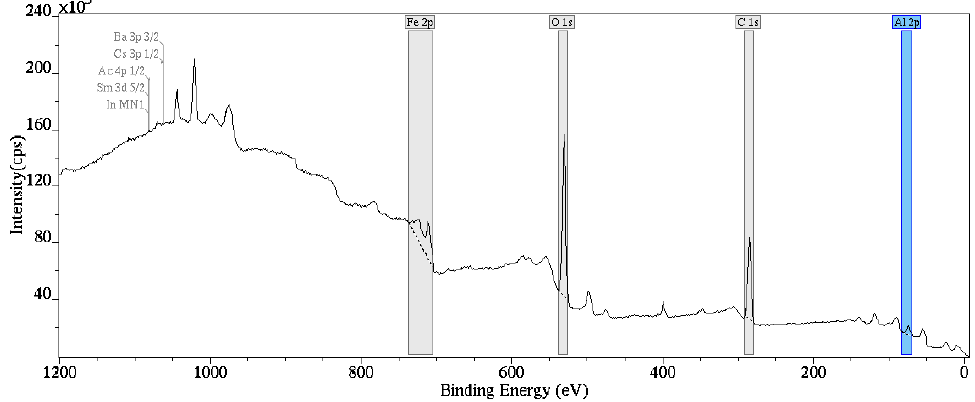
Figure 10. XPS fitting spectra obtained from survey spectrum of eroded API X100 steel at a 90° impact angle and 80 m/s particles speed.